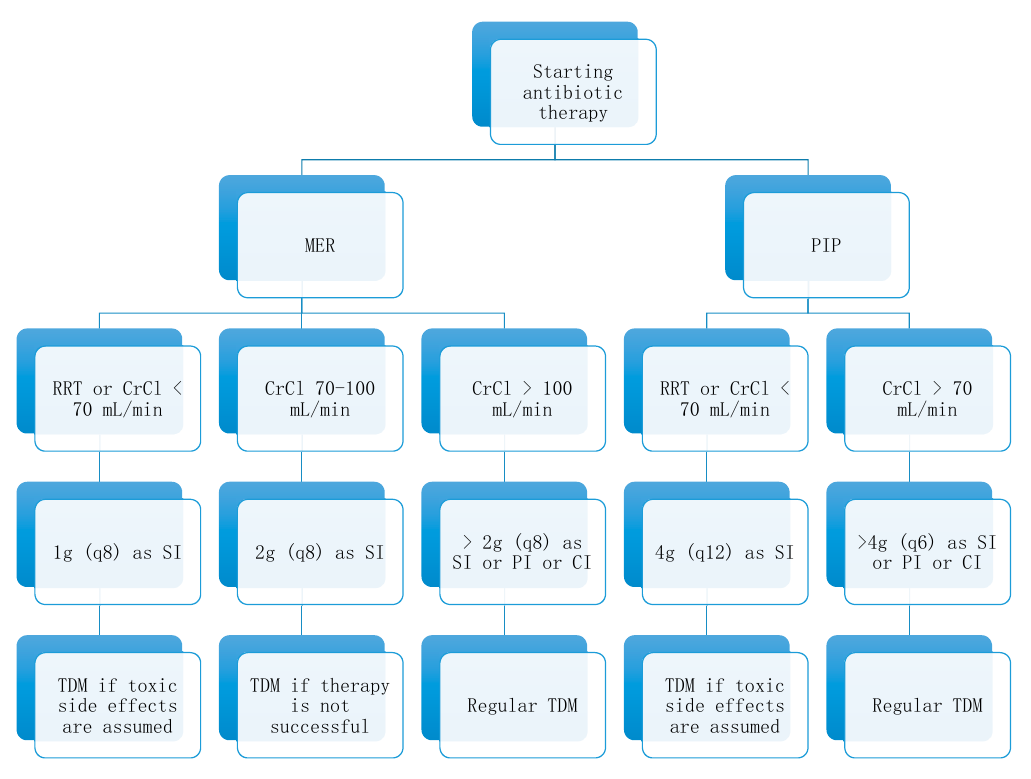
Figure 3. Dosing algorithm for critically ill patients treated with meropenem and piperacillin based on renal function. Note: RRT: renal replacement therapy, CrCl: creatinine-clearance, MER: meropenem, q8: eight-hourly, SI: short infusion = 30 minutes, TDM: therapeutic drug monitoring, PI: prolonged infusion, CI: continuous infusion, PIP: piperacillin, q12: 12-hourly, q6: six-hourly.